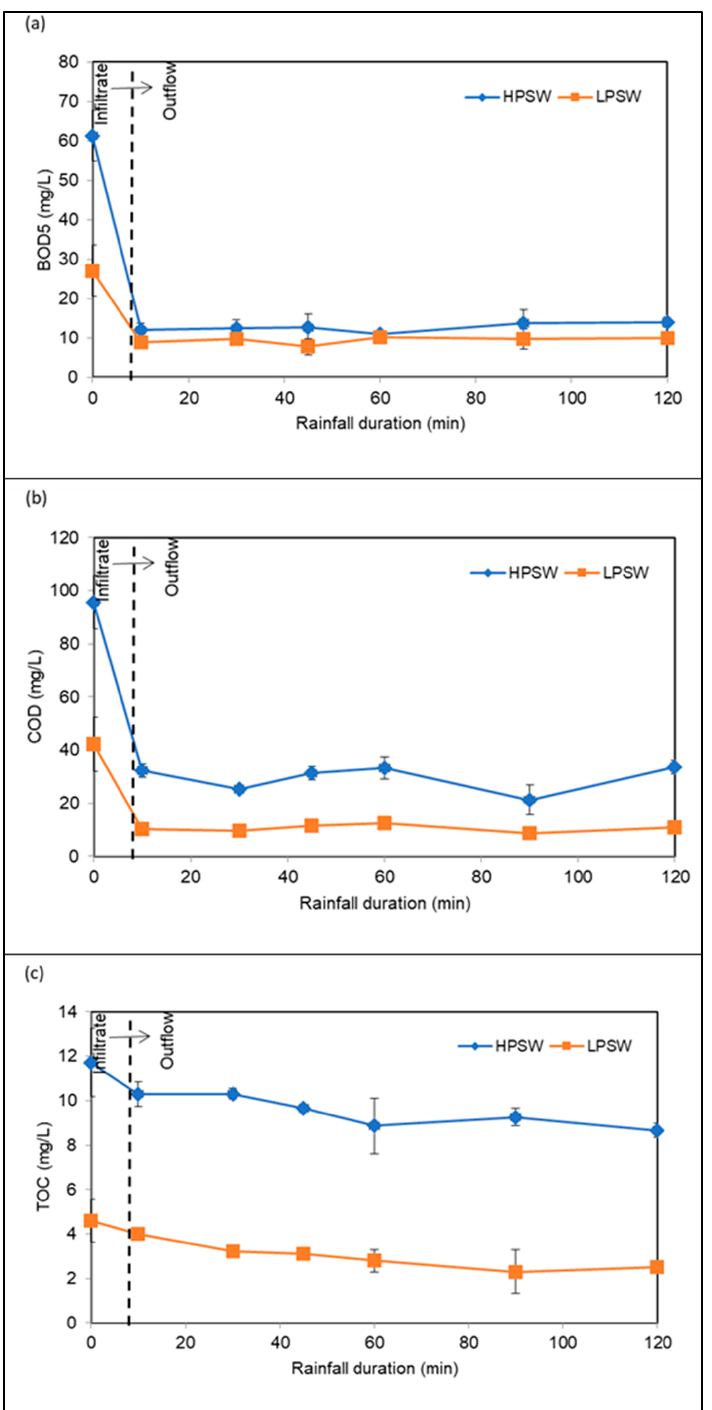
Figure 5. Variations of ( a ) BOD5, ( b ) COD, and ( c ) TOC before and after infiltration through permeable clay